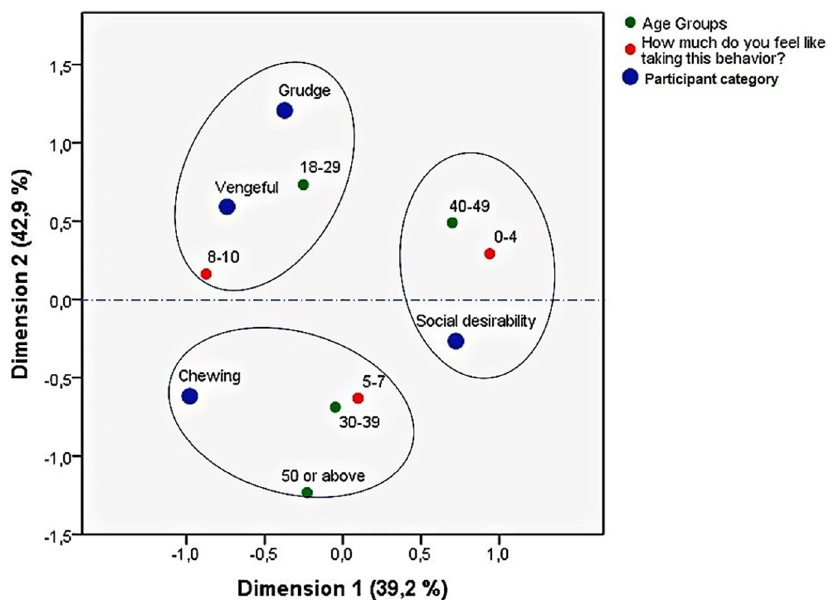
Figure 7. Multiple correspondence analysis map: ARS_13 Age groups and withdrawal levels.